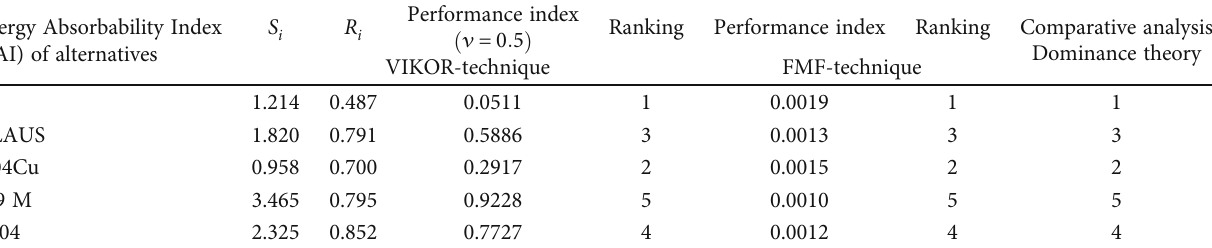
linking TEHES-O-S-tube material dimensions for assessing EAI.